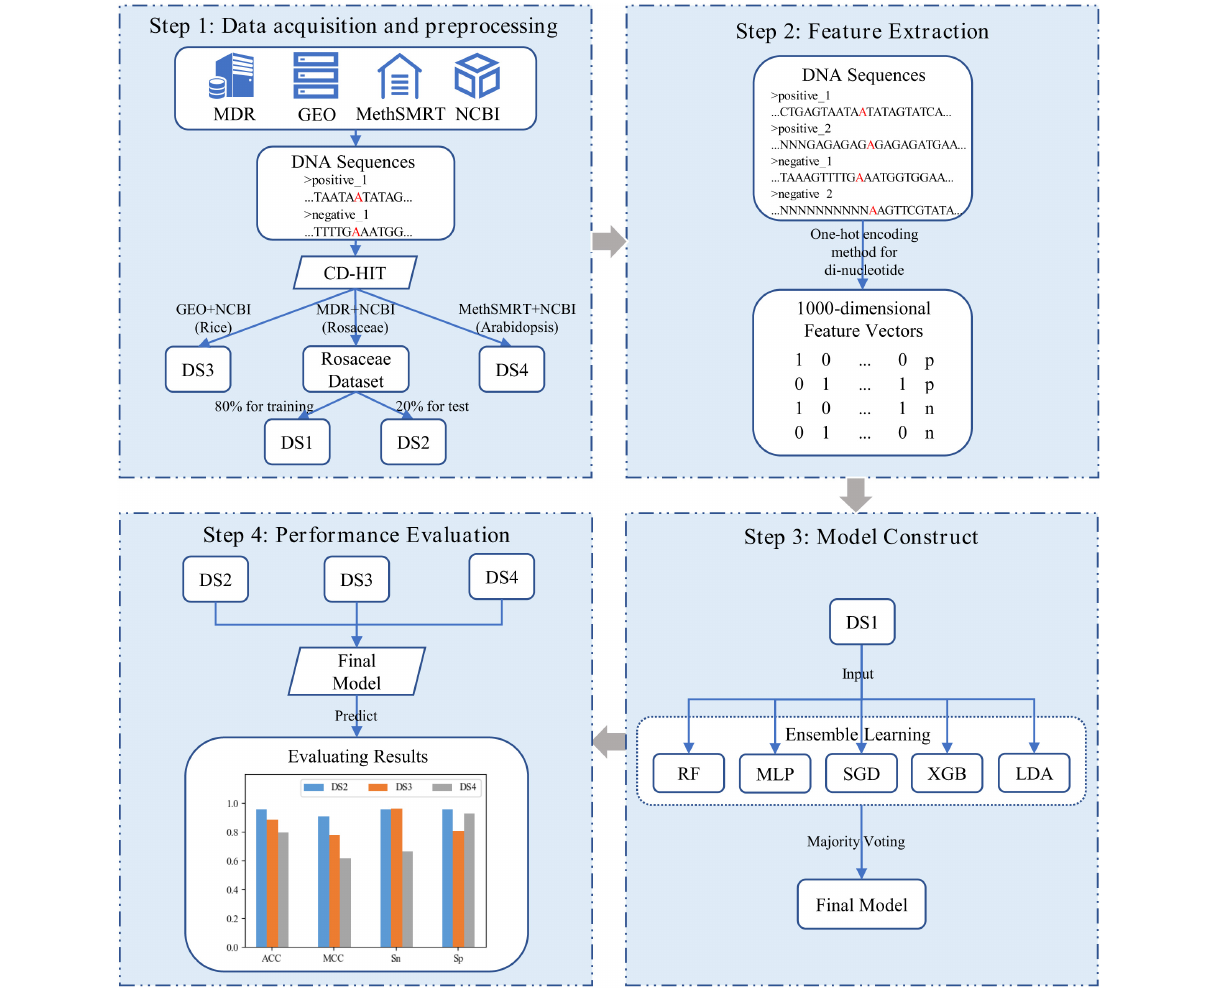
FIGURE 1 | Frame diagram of i6mA-vote. (DS1, DS2, DS3, and DS4 refer to Rosaceae training dataset, Rosaceae test dataset, Rice test dataset, and Arabidopsis test dataset; In the DNA sequences, the letter “A” marked in red refers to the possible 6mA site, and the letter “N” indicates the unidentified nucleotide; In the